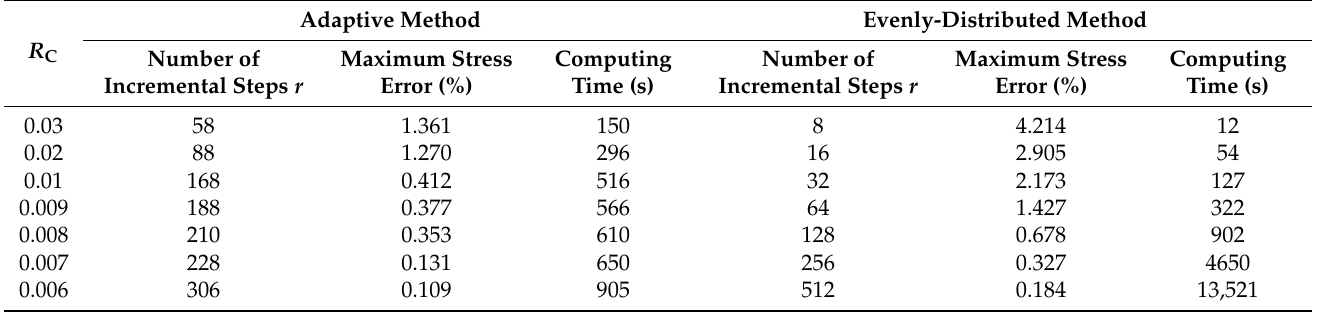
Figure 5. Convergence analysis of the number of incremental steps on four turning points of cyclic loading: ( a ) P ( t 1 ), ( b ) P ( t 2 ), ( c ) P ( t 3 ), and ( d ) P ( t 4 ). Table 1. Comparisons of number of incremental steps and maximum stress error on P ( t 4 ) between the adaptive method and evenly-distributed method.